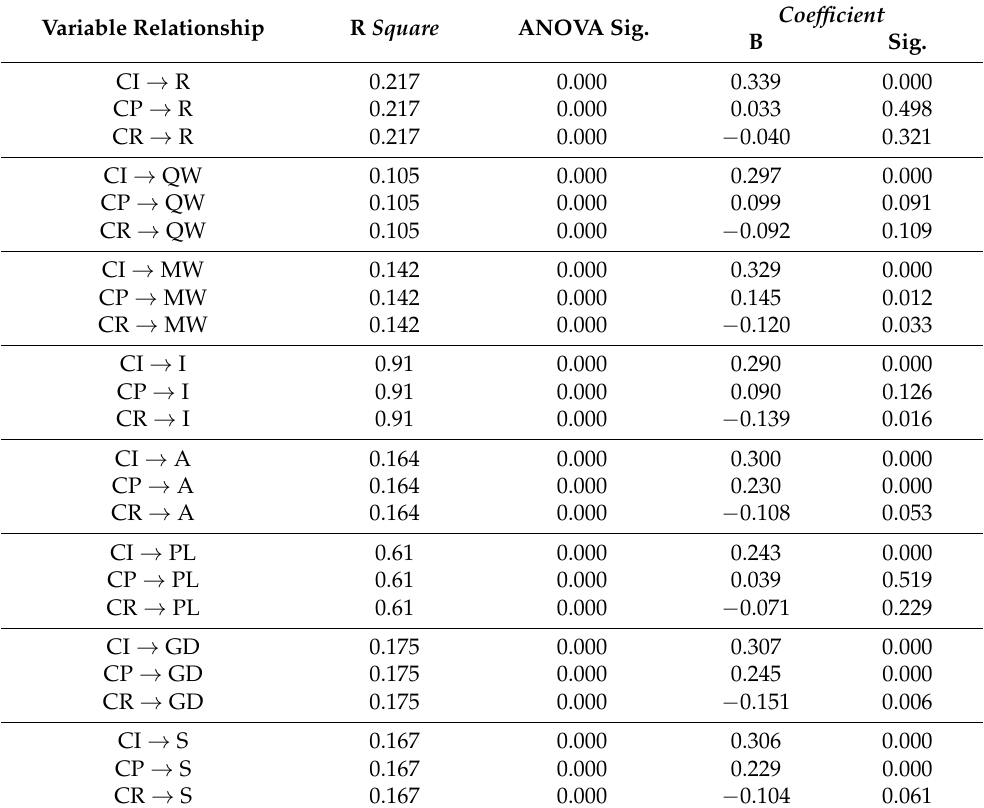
Table 2. Multiple linear regression test of career commitment and subjective career success. Variable